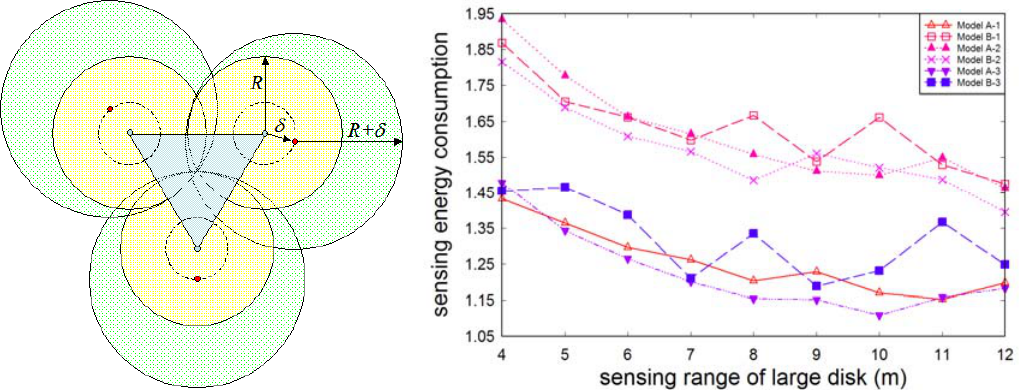
Figure 8. Modified model and sensing energy consumption with 100% coverage ( N =